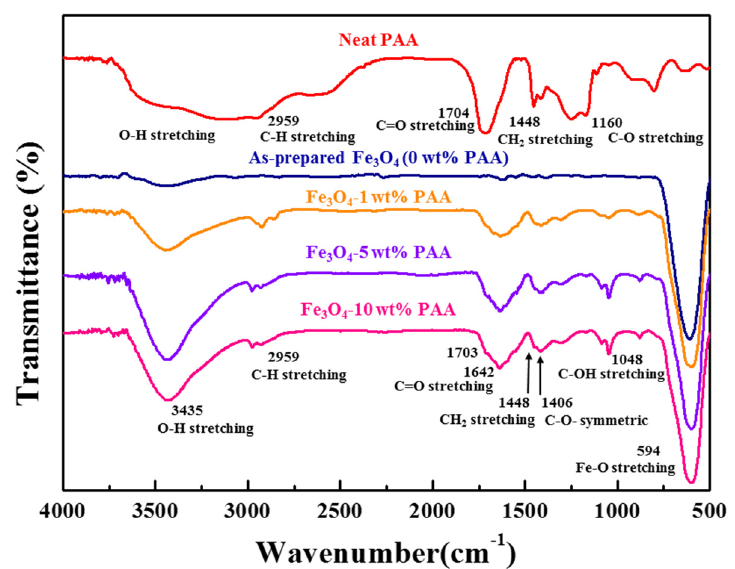
Figure 1. FTIR spectra of as-prepared Fe 3 O 4 and Fe 3 O 4 modified using 1, 5, and 10 wt % PAA.